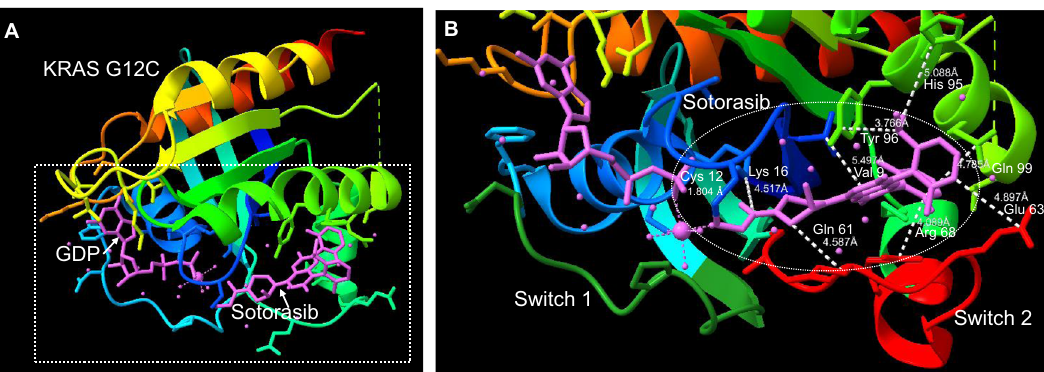
Fig. 2 Crystalline protein structure of KRAS G12C modeled. A General representation of KRAS G12C protein in 3-dimensional space in relationship with bound sotorasib and GDP. The outline box represents area that is focused on in ( B ) view. B Distances between localized KRAS G12C side-chains to sotorasib (in pink, encircled in white) are presented. Switch pockets 1 and 2 are highlighted in dark green and red, respectively. Loci we identi fi ed included: Val9, Lys16, Gln61, Glu63, Arg68, His95, Tyr96, and Gln99. This has been modelled via UCSF ChimeraX 13,14